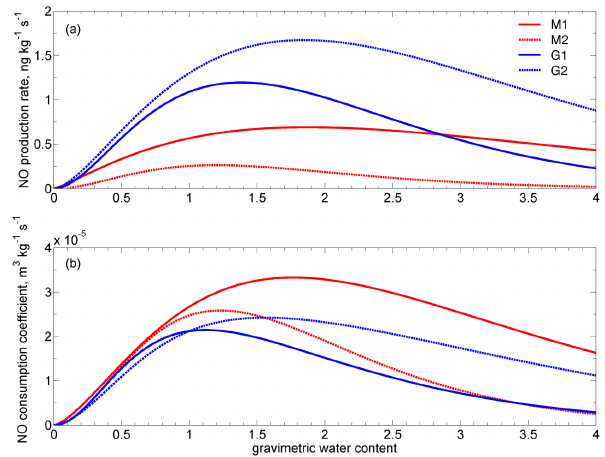
Figure 6. (a) NO production at T soil =10°C and (b) NO consumption coefficient at T soil =10°C from soil samples taken under moss and grass cover (all expressed in terms of mass of nitrogen). The red lines show the production and consumption coefficient of soil samples taken under moss covered patches and the blue lines of soil samples taken under grass covered patches.